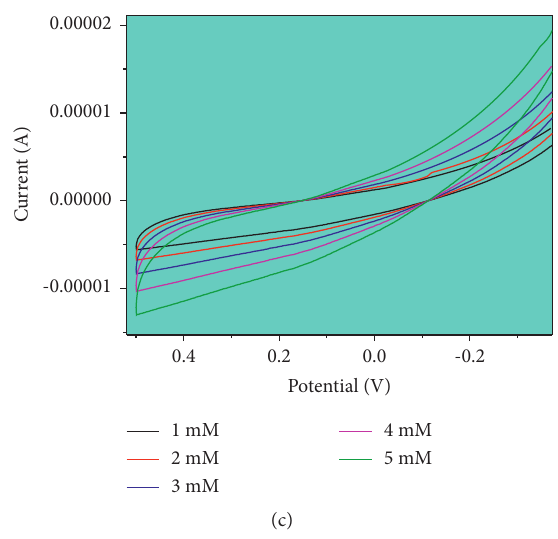
Figure 10: CV plots of Co 3 O 4 ((a) 1 :2, (b) 1:1, and (c) 2 :1) modified CPWE CA sensor.